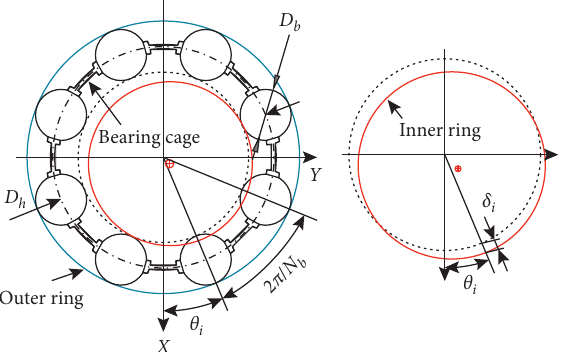
Figure 1: Schematic diagram of the ball bearing and the rela- tionship of the displacement about the i th